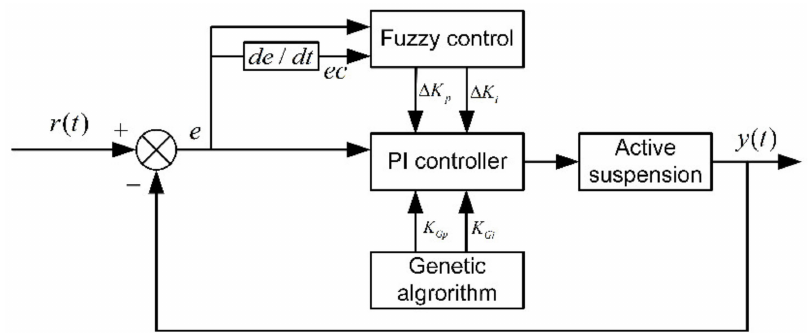
Figure 1. Flow chart of genetic fuzzy PI algorithm.